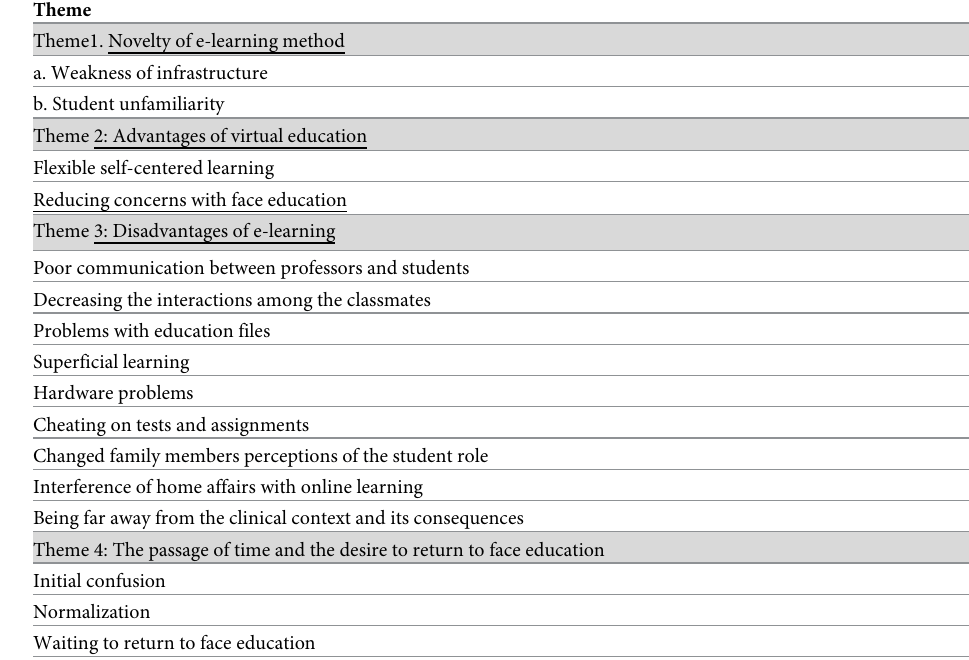
Table 1. Theme and